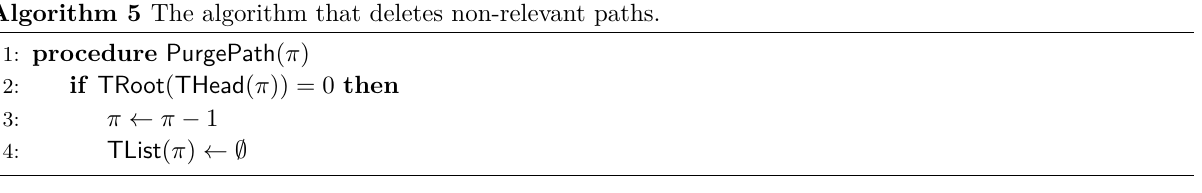
Algorithm 6 The algorithm that merges two subtrees containing paths π 0 and π 00 .